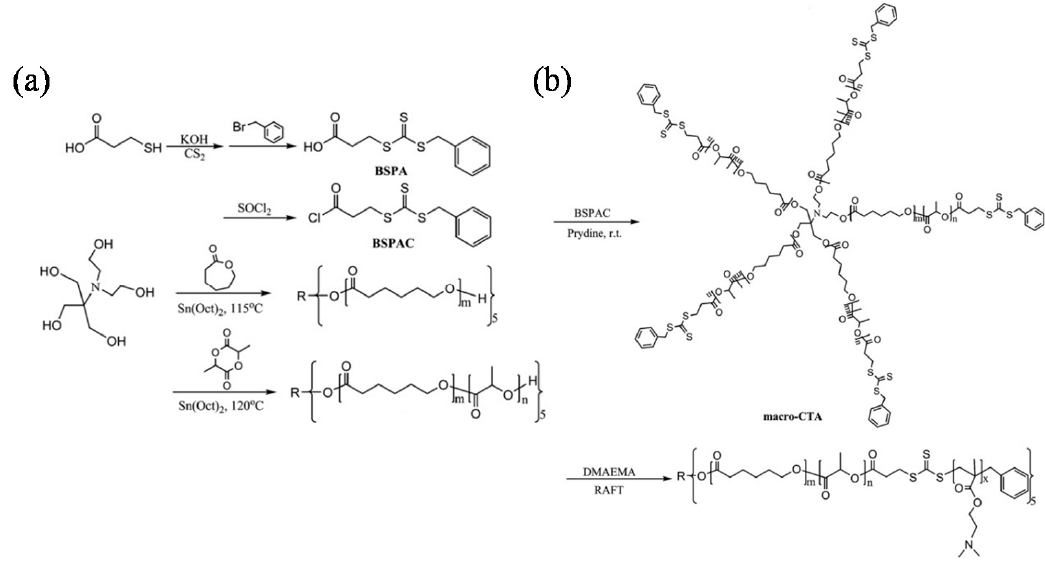
Figure 3. Synthesis of the star-block amphiphilic copolymer via ring-opening polymerization ( a ) and RAFT polymerization ( b ). Copyright 2010, Elsevier.